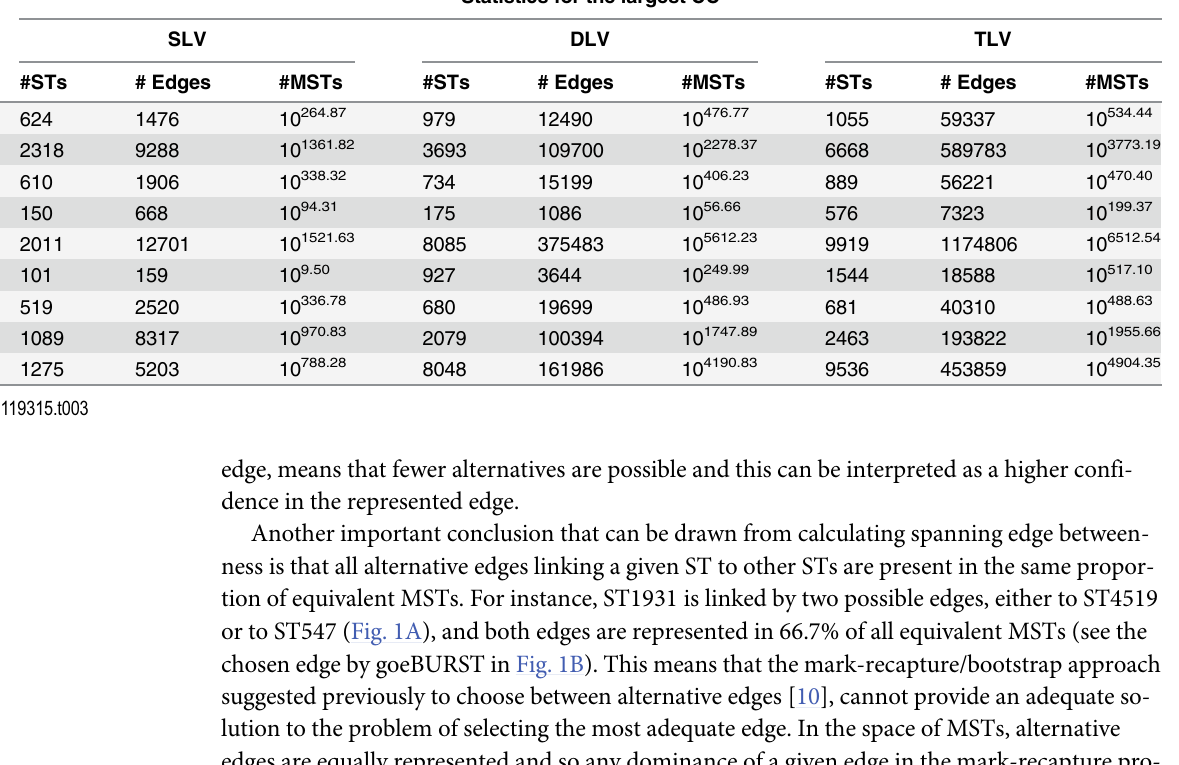
Table 3. Statistics relative to the largest CC linking STs at the SLV, DLV and TLV levels of construction. SLV means that the graph contains only edges linking STs that are SLVs, DLV means that edges were drawn between STs that are SLVs or DLVs of each other, and TLV that edges were drawn between STs that are SLVs, DLVs or TLVs of each other, according to the rules implemented in goeBURST. Data sets